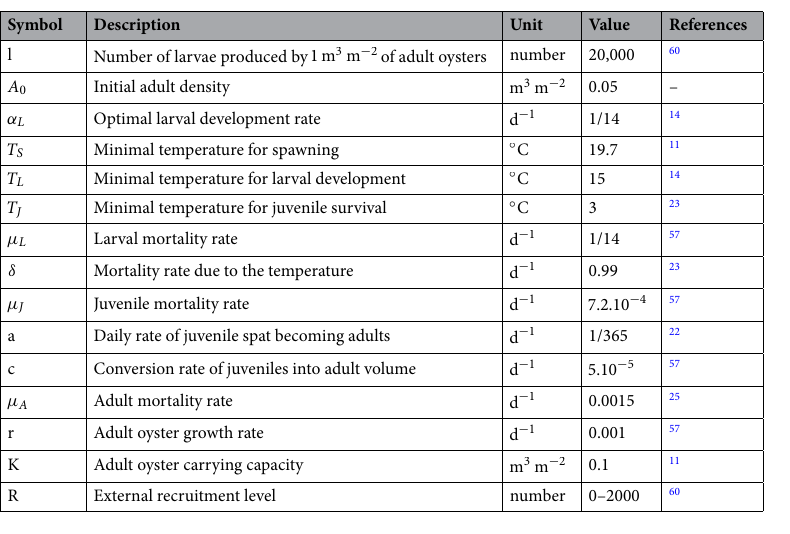
Table 1. Parameters for models (1)–(6).